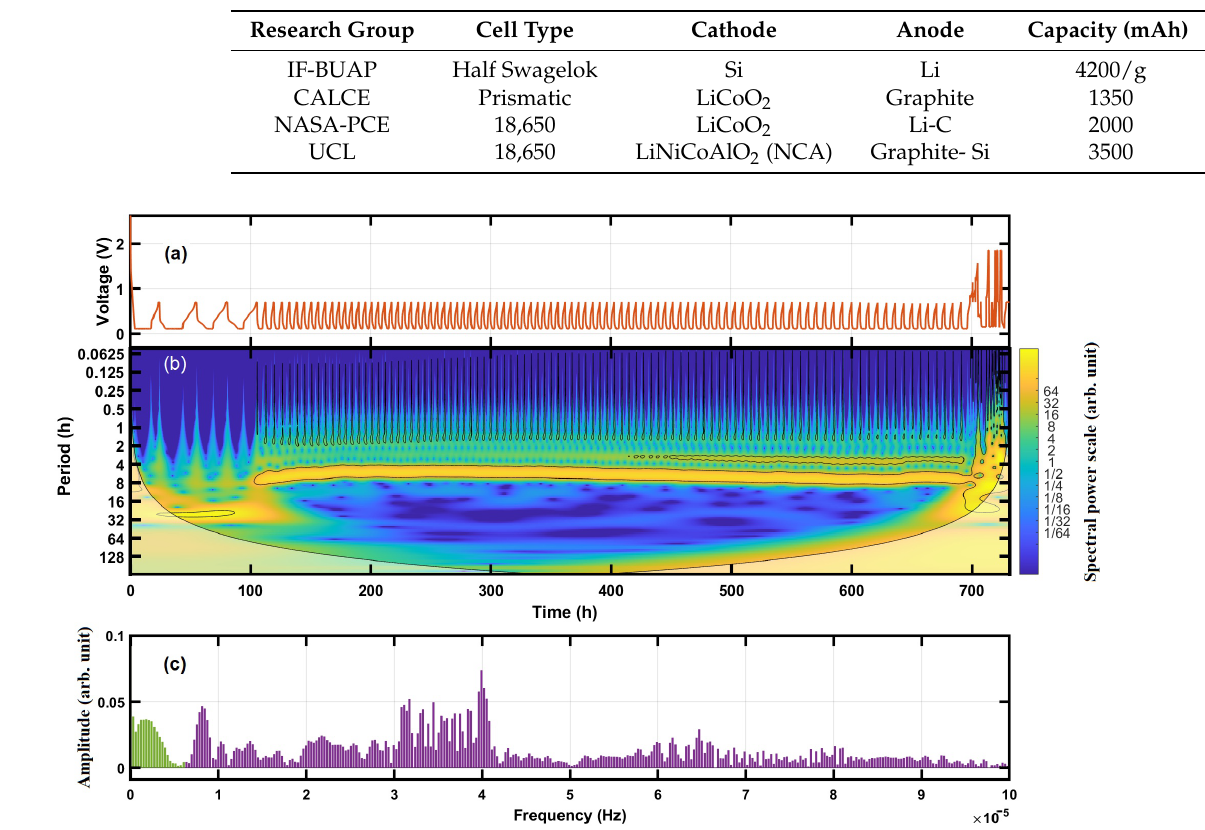
Table 1. Lithium-ion cell evaluated by the fourth research groups.